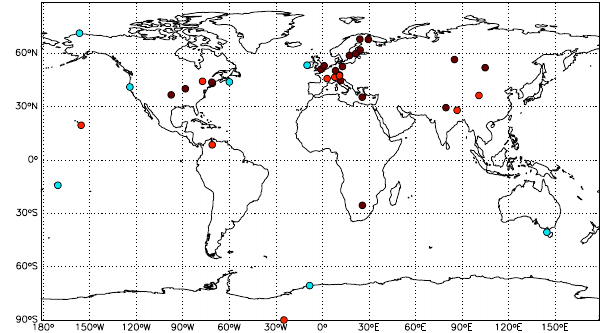
Fig. 2. Location of observation sites used in this analysis classified as in Table 2: FT (red), MBL (blue), continental BL